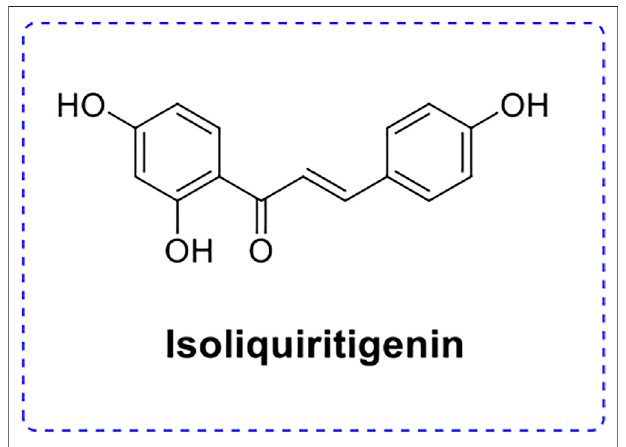
FIGURE 1 | The chemical structure of isoliquiritigenin.